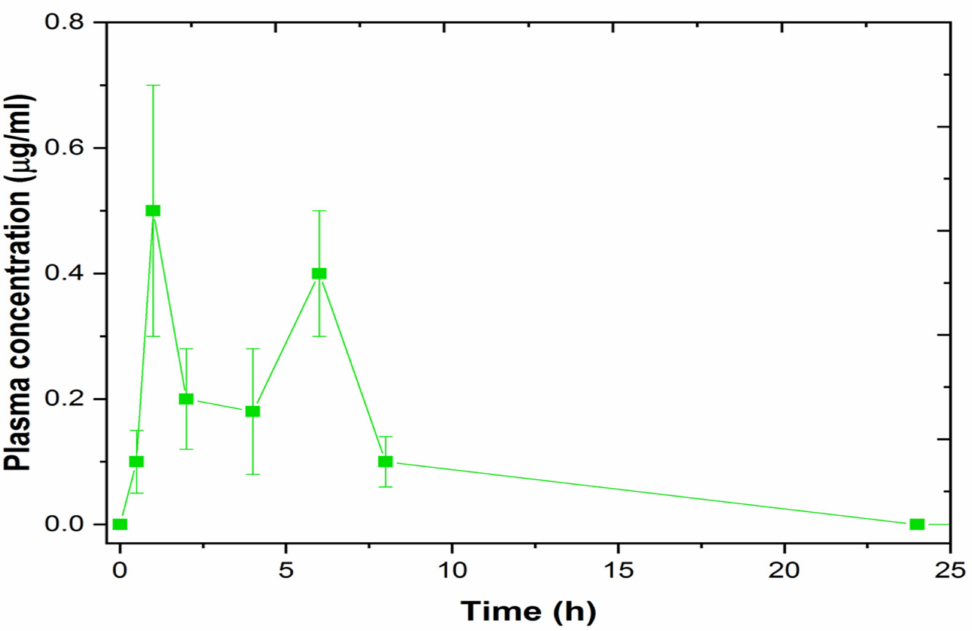
Figure 17. Graph showing the plasma concentration–time profile of levosulpiride after administration oral dispersion of levosulpiride to mice (at a dose of 200 mg/kg) (mean ± SD, n = 4). As shown in the Table 3, the t 1/2 of the LS-TC-MNP-3 increased to 11.04 ± 4.2 h, which is higher than that of the oral LS dispersion (5.24 ± 2.1 h). LS-TC-MNP-3 has a C max of